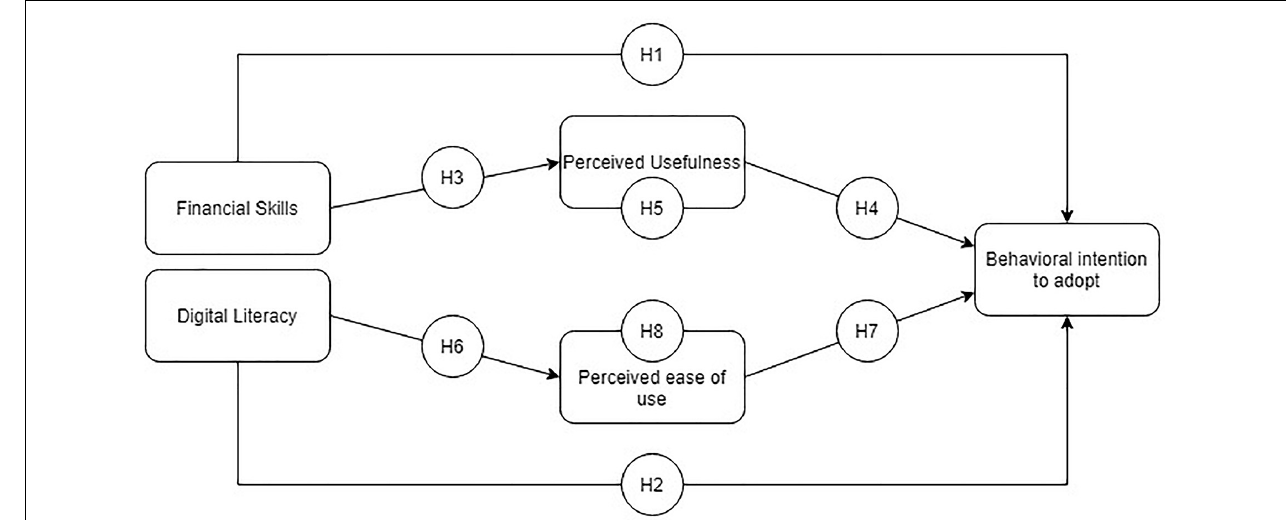
FIGURE 1 | Research model and